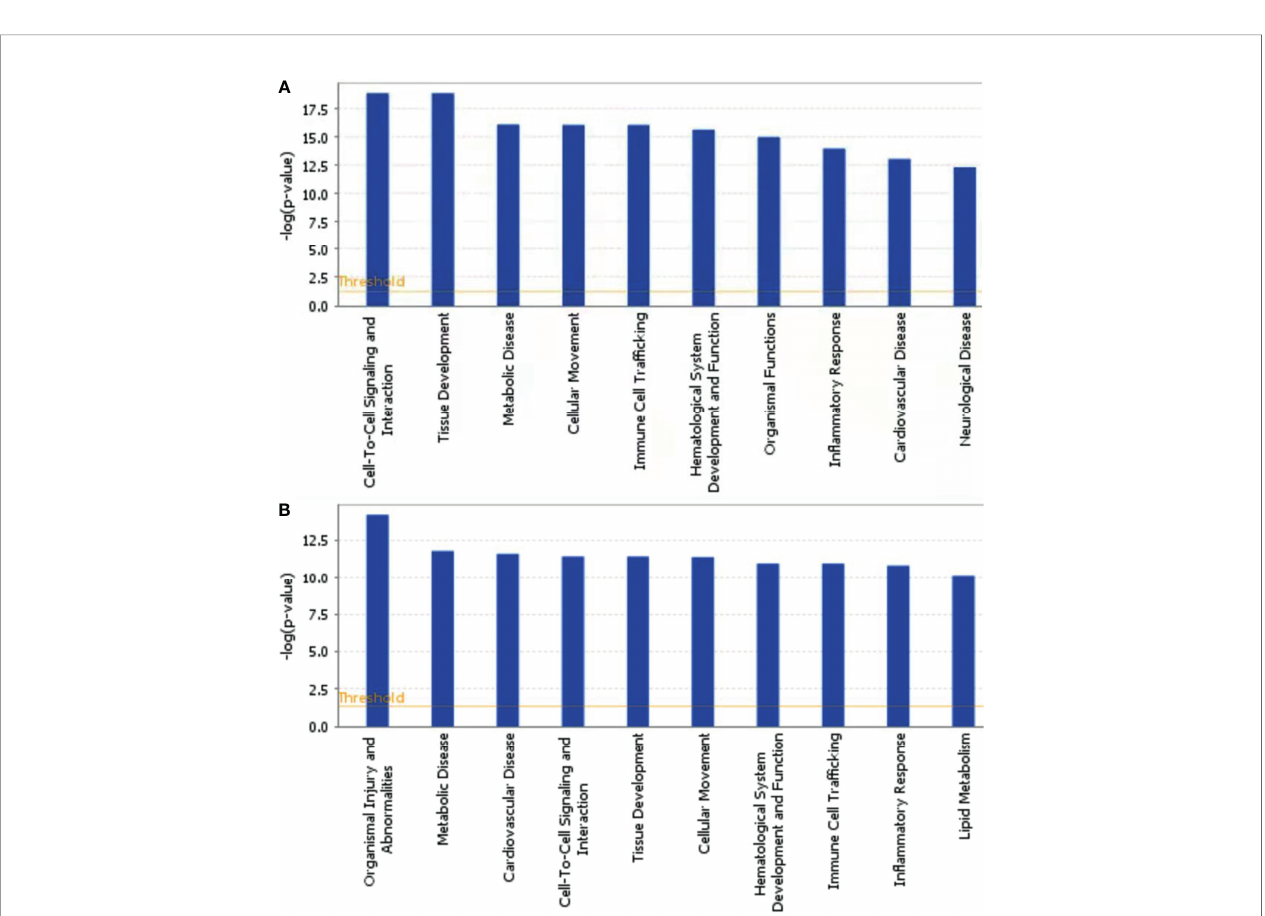
FIGURE 3 | Predominant molecular functions based on differentially expressed proteins in B-NHL (A) and T-NHL (B) compared with the control. The cutoff of p value was set to